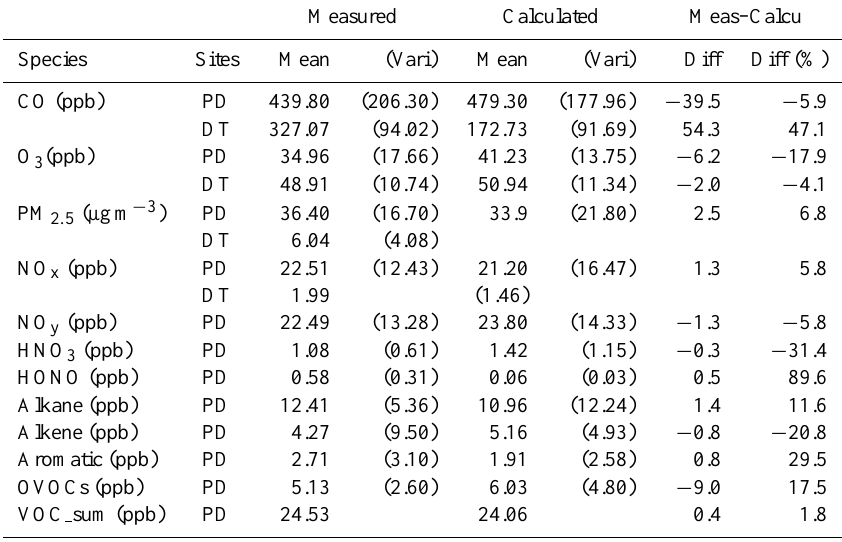
Table 2. Comparison of the calculated mean values (variances) at the PD and DT sites with the measured results.